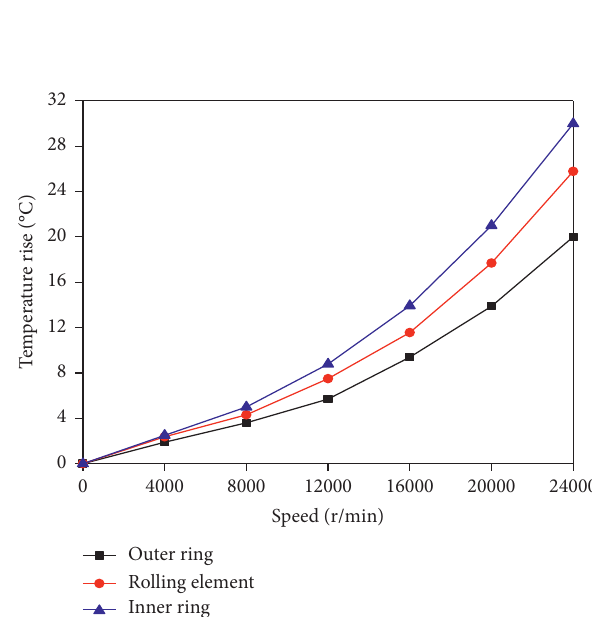
Figure 8: Influence of speed on temperature rise of bearing